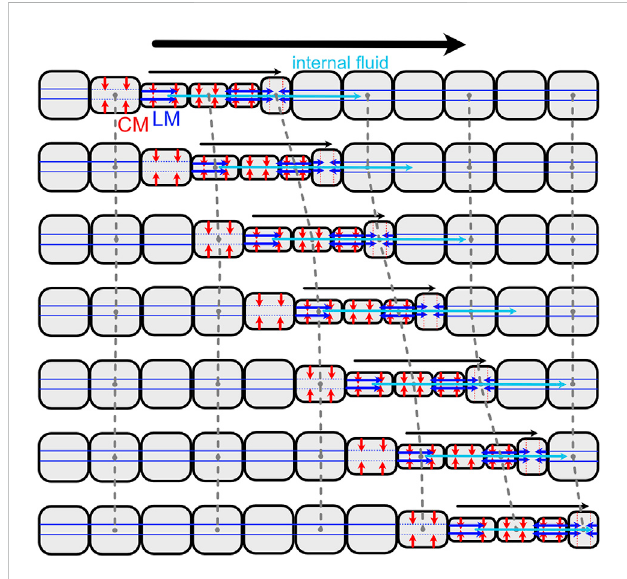
FIGURE 8 Diagram of direct peristalsis, following peristalsis by Thoracophelia mucronata (Figure 2). The wave of circular muscle contraction travels toward the head, starting with contraction of the circular muscles (CM; red) to reduce the diameter, then contraction of the longitudinal muscles (LM; blue) to pull the narrow segment forward. Internal fl uid (cyan) moves between segments, e.g., being pushed forward as the contractile wave moves forward.